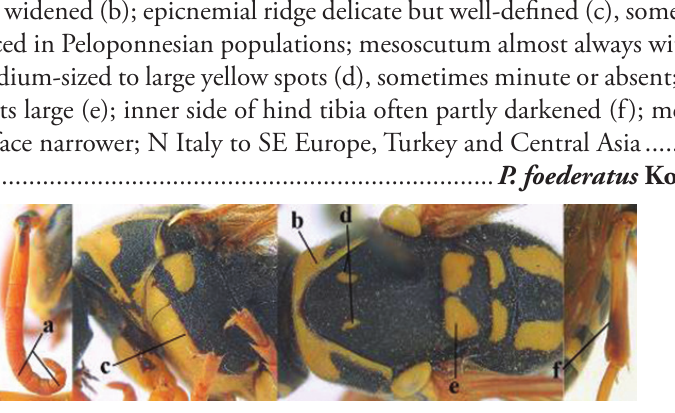
– Antenna dorsally dark brown (aa); pronotal transverse yellow band narrow (bb); epicnemial ridge indistinct (cc); mesoscutum with yellow spots minute or absent (dd); scutellar spots small (ee); inner side of hind tibia rather pale (ff); medial area of face wider; C Europe, temperate Asia .............................. ................................................................. P. albellus Giordani Soika,